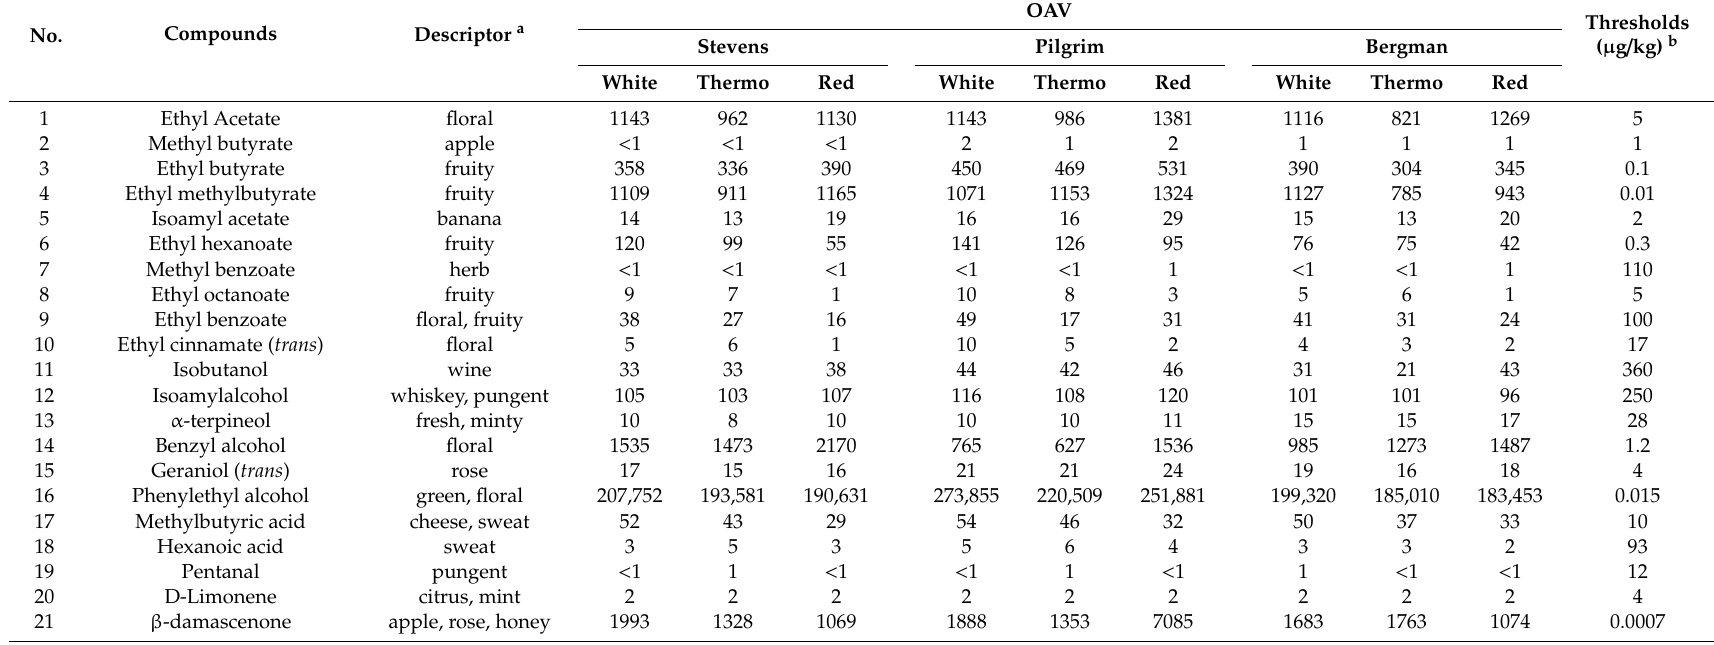
Table 4. OAVs (odour activity values) and descriptors of volatile compounds detected in cranberry